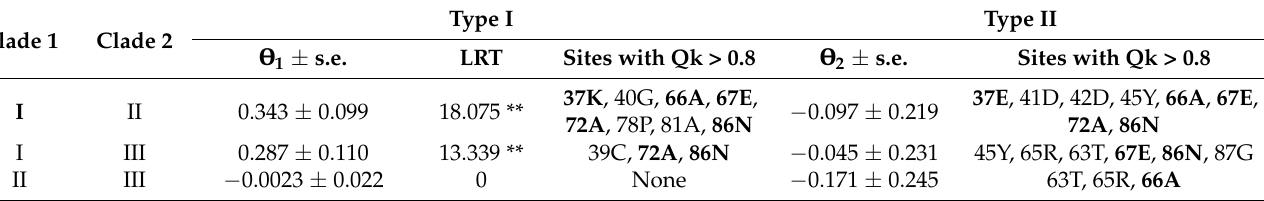
Table 1. Functional divergence of TaGATA proteins *.